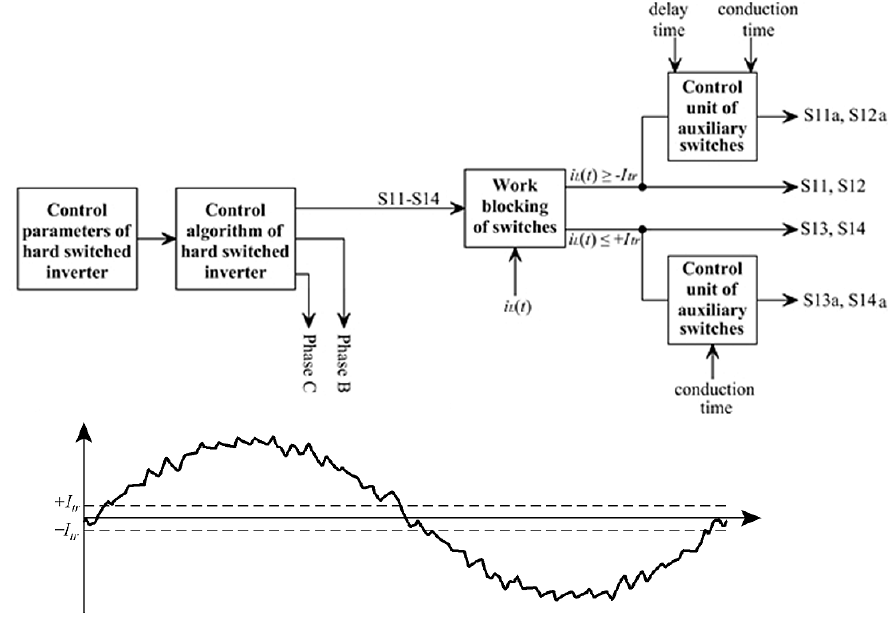
Figure 8. Generation of control signals of switches.